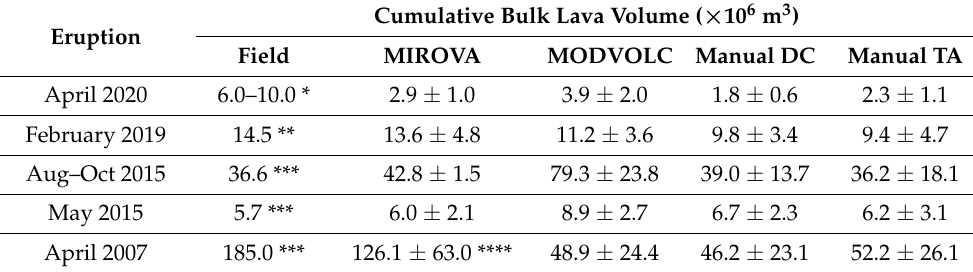
Table 2. Estimated total bulk volumes of erupted lava ( × 10 6 m 3 ) from field measurements, the MIROVA and MODVOLC systems, and manual analysis. Manual DC corresponds to the direct conversion from spectral radiance, and Manual TA is the thermodynamic approach.